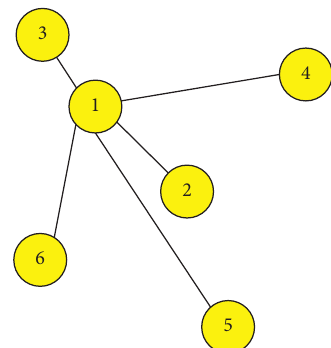
Figure 4: The situation of the traditional ant colony algorithm in the early iteration.